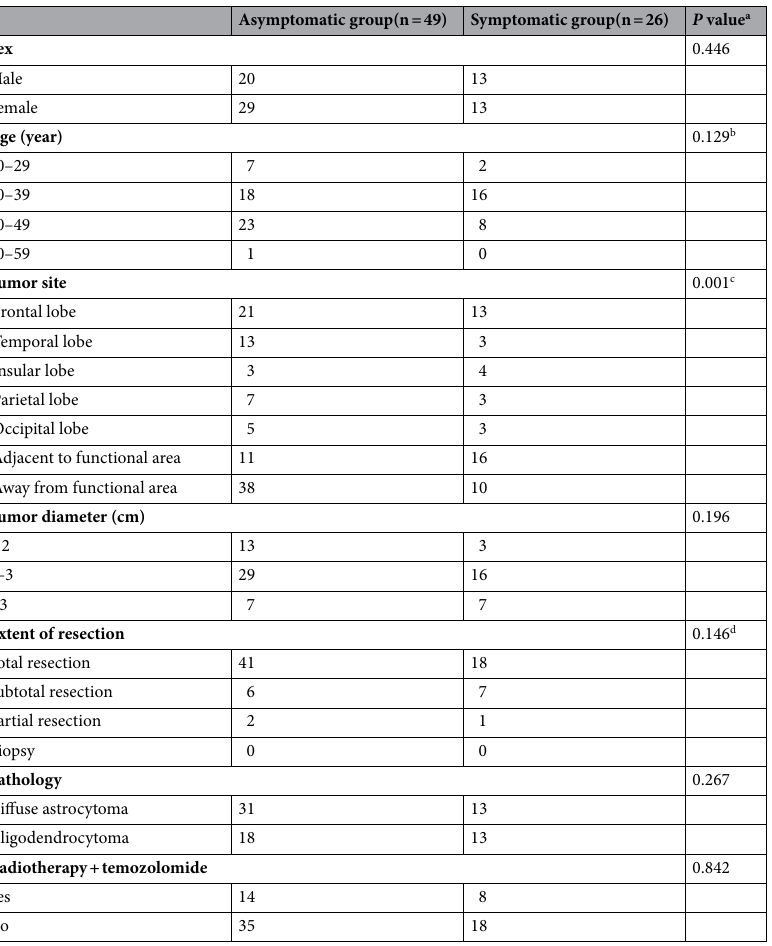
Table 2. The clinical characteristics of incidental low grade glioma classified into asymptomatic or symptomatic group. a P value based on Chi-squared test. b The group of “age ≤ 39” was compared with the group of “age > 40”. c The group of tumor site “adjacent to functional area” was compared with the group of “away from functional area”. d The group of “total resection” was compared with the group of non-total